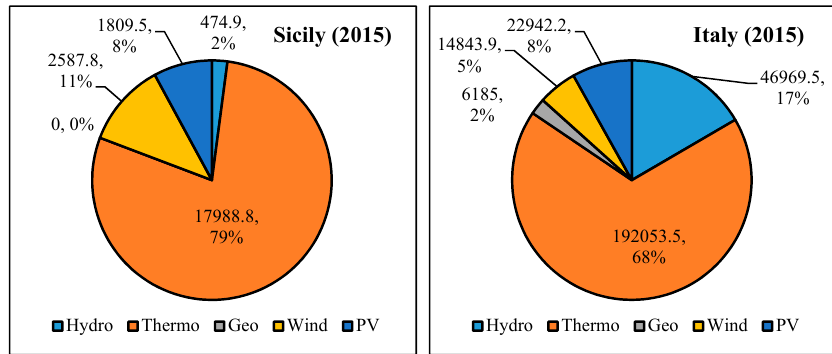
Figure 2. Comparison of gross electricity production (GWh) in 2015 by sources in Sicily and Italy.